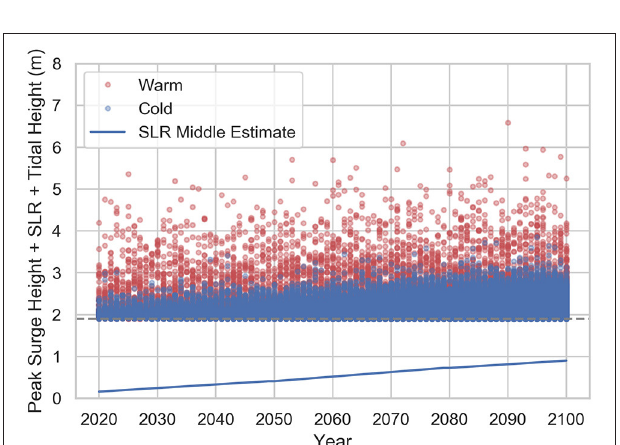
FIGURE 7 | One thousand simulations of randomly generated storms expressed through their corresponding peak water levels (peak storm surge + SLR + tidal height) over the 80-year period considered (2020–2100). The blue dots depict peak storm surges in cold season. The red dots depict peak storm surges in warm season. Middle SLR estimate (Horton et al., 2015; Gornitz et al., 2019) is considered. SLR is denoted by the continuous sloped blue line. The dashed horizontal gray line indicates the 1.9 m threshold, below which there is no flooding observed in Lower